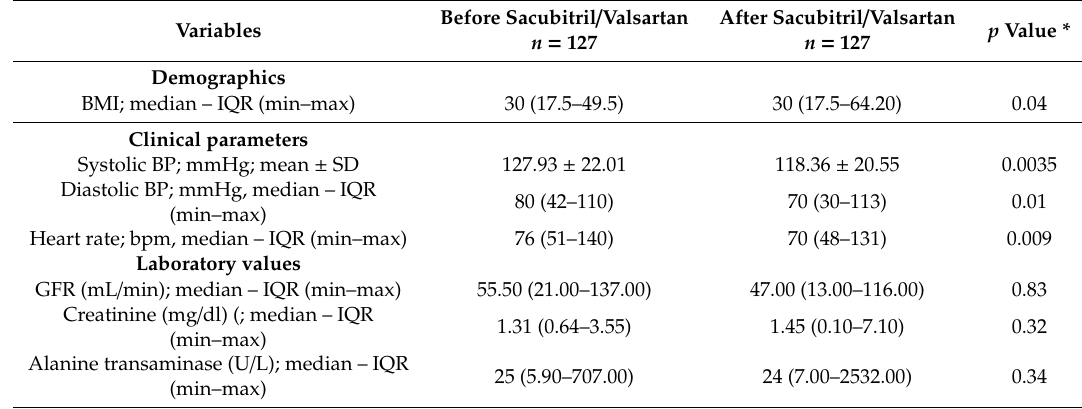
Table 1. Baseline characteristics of the 127 patients initially presenting before and after sacubitril / valsartan. Before Sacubitril / Valsartan After Sacubitril / Variables n = 127